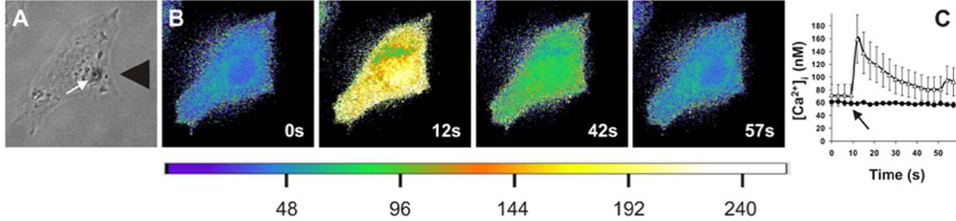
Figure 2. Application of extracellular stress leads to increased intracellular calcium concentrations. Matthews et al. applied high levels of stress to cells ( A ) and found that when imaged via Fura-2AM ratio imaging, it led to a transient increase in calcium concentrations, as shown in pseudocolor images ranging from blue to yellow ( B ) that is quantified ( C ) as a function of time for control and gadolinium chloride-treated cells. (Figure reprinted/adapted with permission from Ref. [61]. Copyright 2006, National Academy of Sciences . Table 1. Mechanotransducers of various mechanical properties and human cellular responses.